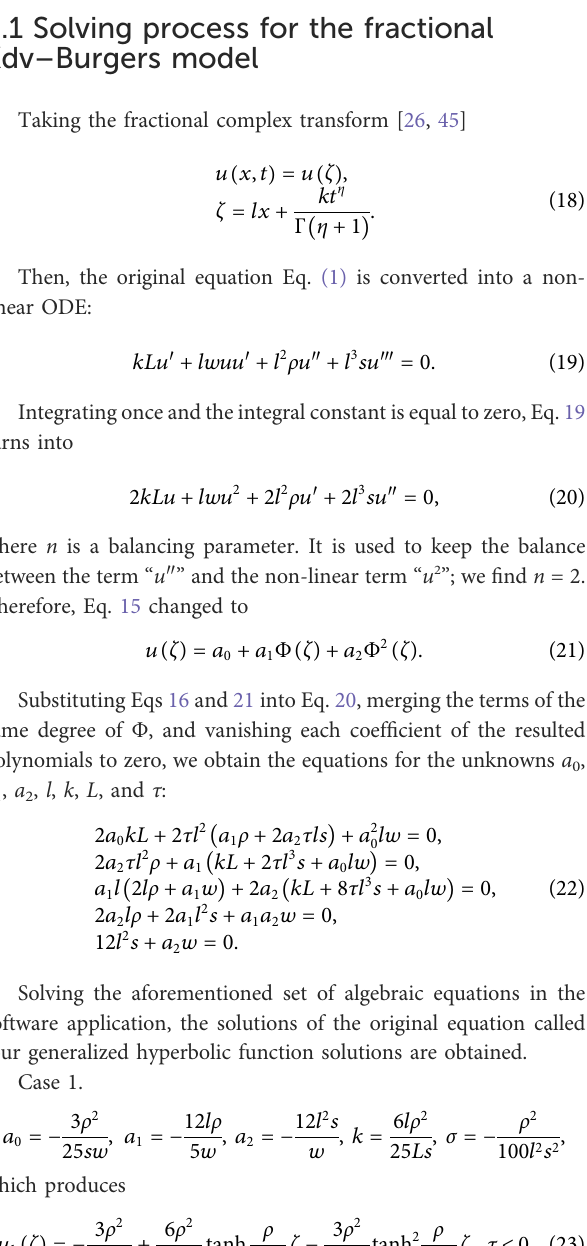
where ζ (cid:2) lx + kt η Γ ( η + , l is an arbitrary constant, and l ≠ 0. 1 ) Figure 1 is the 3D plots of the obtained solutions of the KdVB equation in case 1 for η = 0.5, w = 1, ρ = 1, s = 1, l = 1, and L = 1.